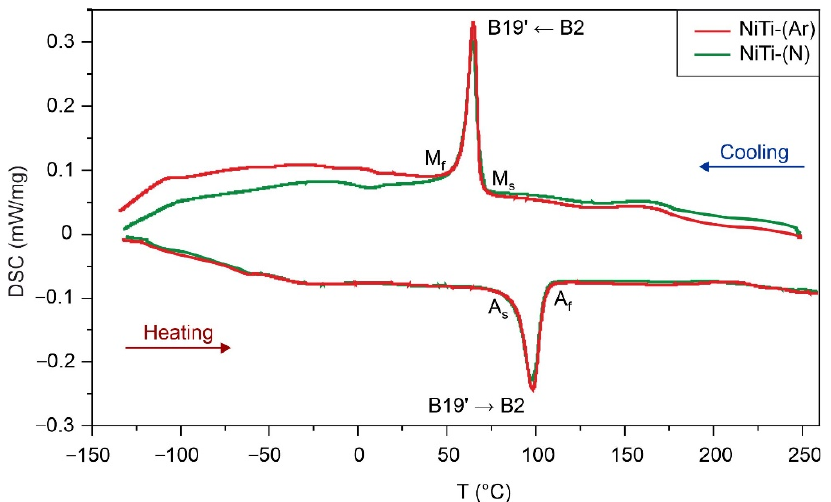
Figure 11. DSC curves of NiTi–(Ar) and NiTi–(N) samples.